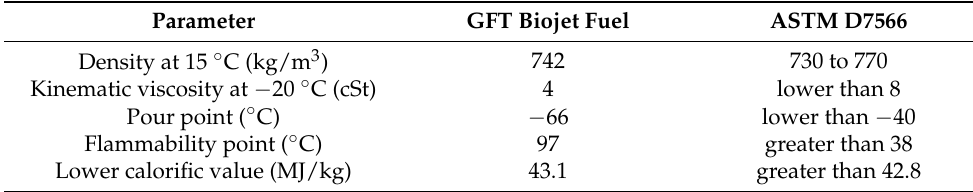
Table 13. Properties of biojet fuel compared to ASTM D7566 standard. Parameter GFT Biojet Fuel ASTM D7566 Density at 15 ◦ C (kg/m 3 ) 742